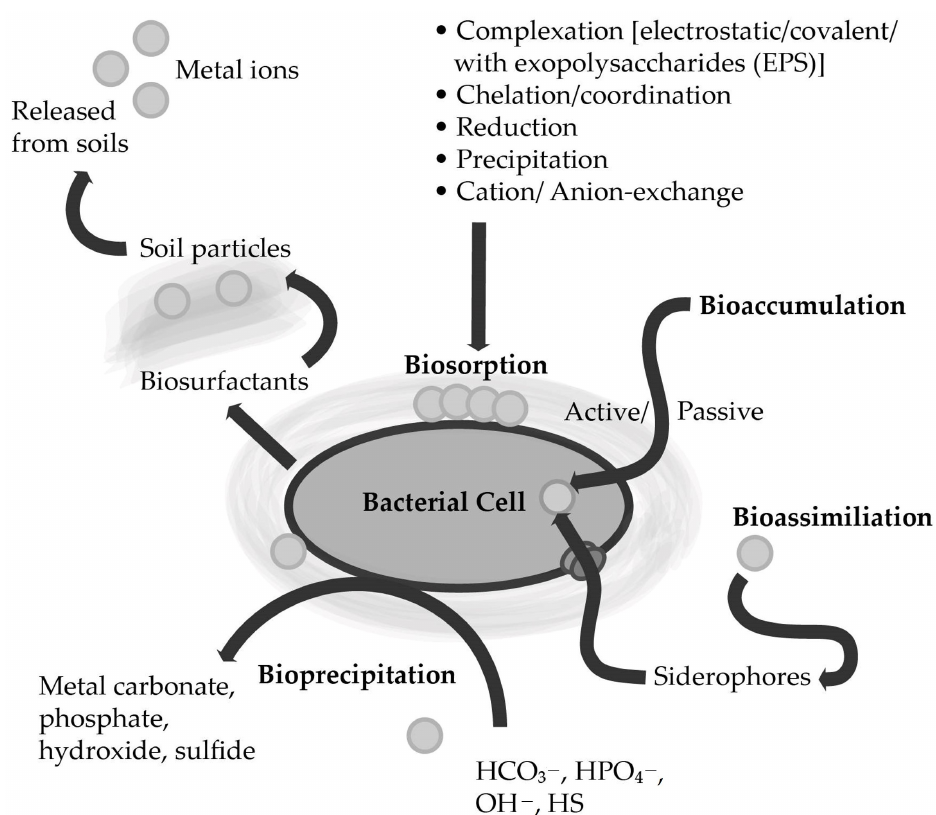
Figure 2.Figure 2. Various types of bacterial interactions with heavy metals accumulated in soils (according to Ahemad [56];